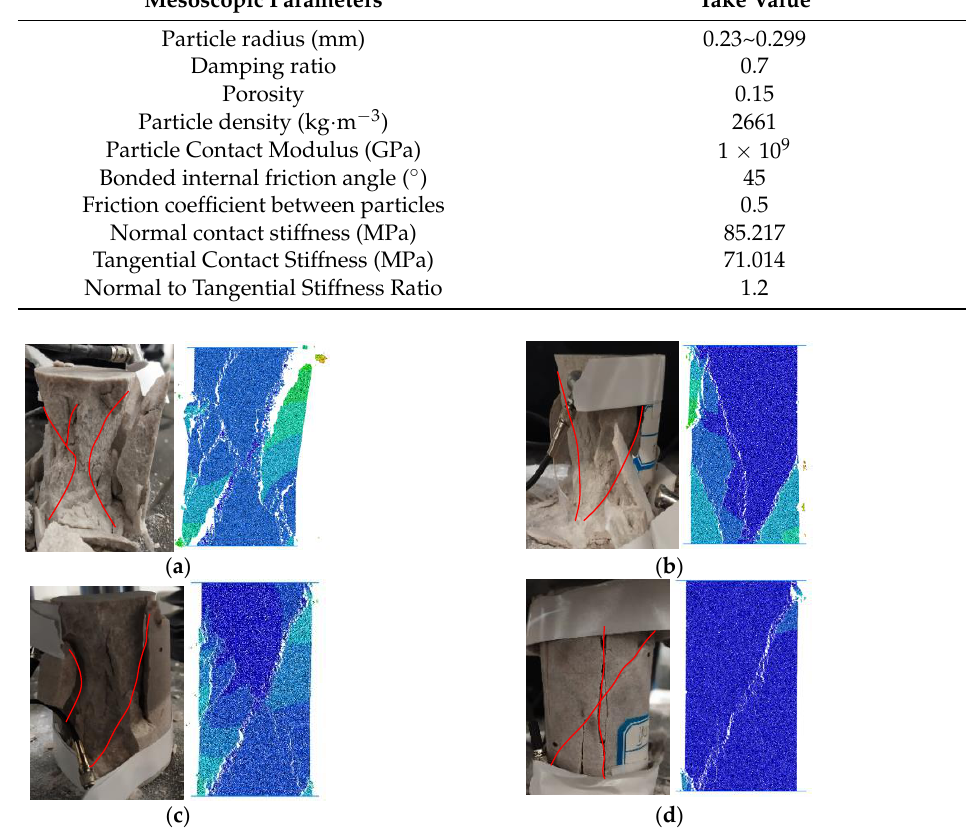
Figure 7. Failure forms of sandstone with different height-to-diameter ratios.( a ) L/D = 1.6 ( b ) L/D = 1.8 ( c ) L/D = 2.0 ( d ) L/D = 2.2 Table 2. Basic mesoscopic parameters of PFC numerical simulation.